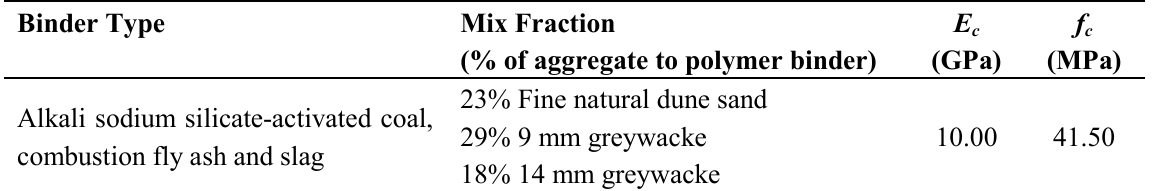
Table 2. Composition and mechanical properties of the polymer concrete (type GFA 45 in [12]). Binder Type